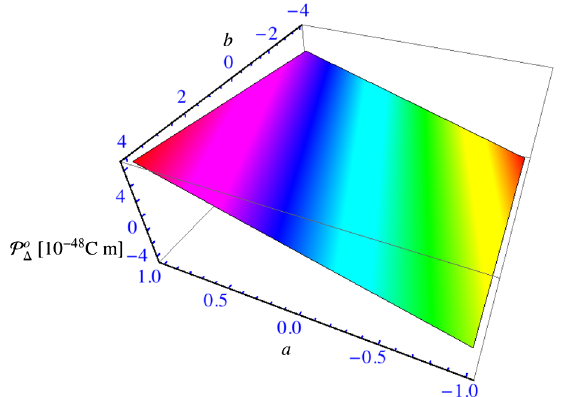
FIG. 4. Plot of a numerical result for the signal function given , for 133 Cs , depending on a and b . in Eq. (3.47), denoted as P o (cid:3) The a and b parameters describe the magnetic field in the y ð t Þ ¼ (cid:10) ð static Þð a þ bt 2 Þ . direction as (cid:10) y y